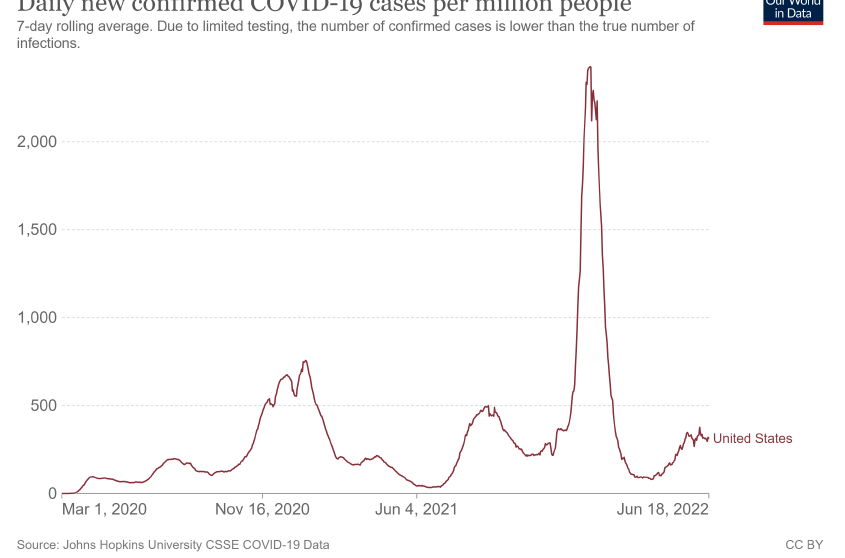
Figure 25. Source: Johns Hopkins University CSSE COVID-19 data. Note: U.S. daily new confirmed COVID-19 cases per million